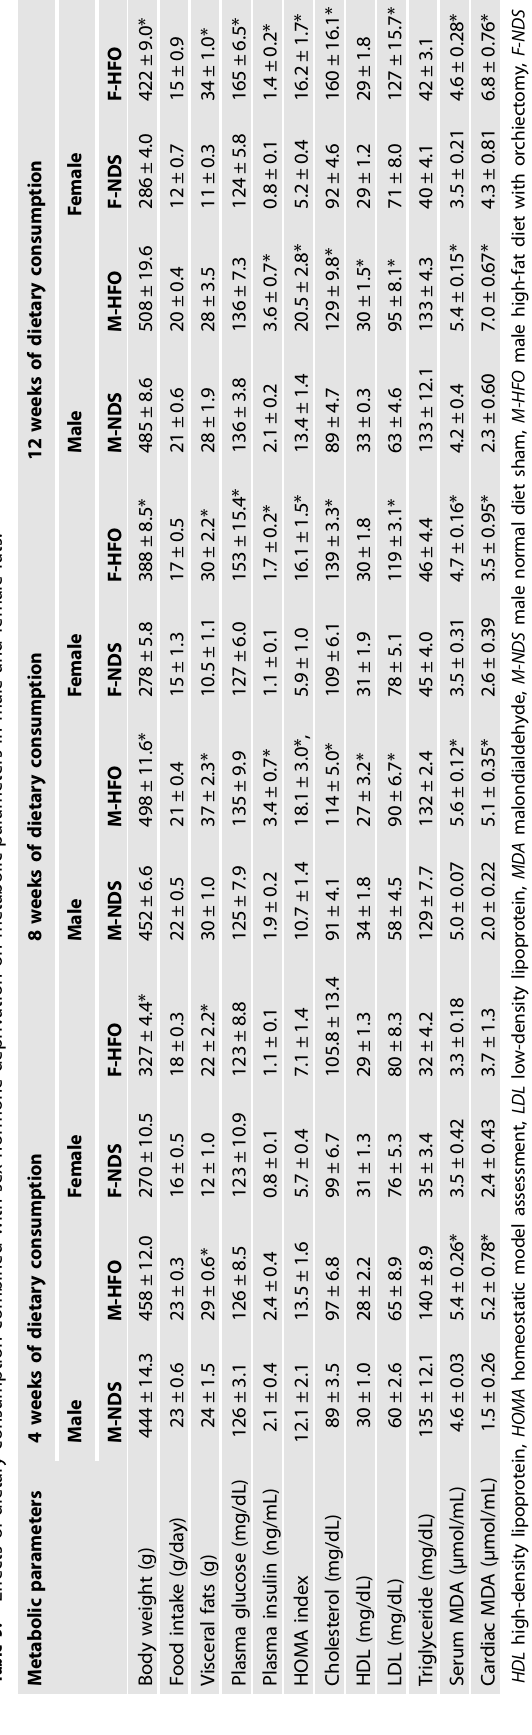
(Fig. 5) when compared with age-matched M-NDS. In M-HFS group, the cardiac mitochondrial dysfunction was detected at week 8 (Figs. 3B, 4B, and 5B). In female rats, the surrogate of cardiac mitochondrial function did not differ among groups at week 4 (Figs. 3A, 4A, and 5A). At week 8, an impaired cardiac mitochondrial function was found only in F-HFO group (Figs. 3B, 4B, and 5B). Interestingly, both F-OVX and F-HFS rats exhibited cardiac mitochondrial dysfunction at week 12 (Figs. 3C, 4C, and 5C). In addition, for the cardiac mitochondrial ROS production, we found that there was no statistically signi fi cant three-way interaction between gender, food and hormone at week 4, F (1, 16) = 2.027, P = 0.174. However, there was a statistically signi fi cant three-way interaction between gender, food and hormone at week 8 ( F (1, 16) = 7.742, P = 0.013) and week 12 ( F (1, 16) = 12.981, P = 0.002). Interestingly, there was no statistically signi fi cant three-way interaction between gender, food and hormone at all time points on the alteration of cardiac mitochondrial membrane potential. For the cardiac mitochondrial swelling, there was a statistically signi fi cant three-way interaction between gender, food and hormone only at week 8, F (1, 16) = 10.957, P =